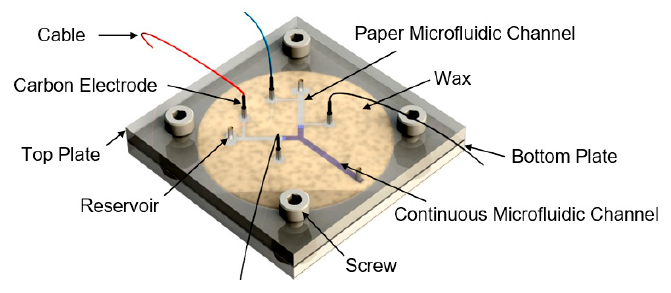
Figure 1. Demonstration of the microfluidic system with paper based electro-osmotic